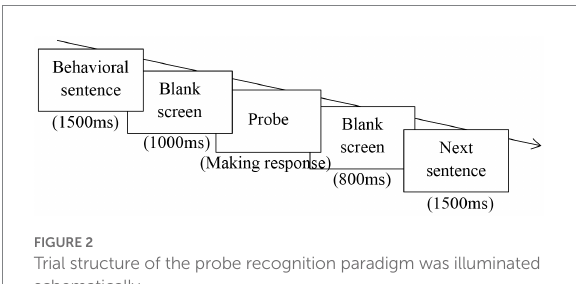
FIGURE 2 Trial structure of the probe recognition paradigm was illuminated